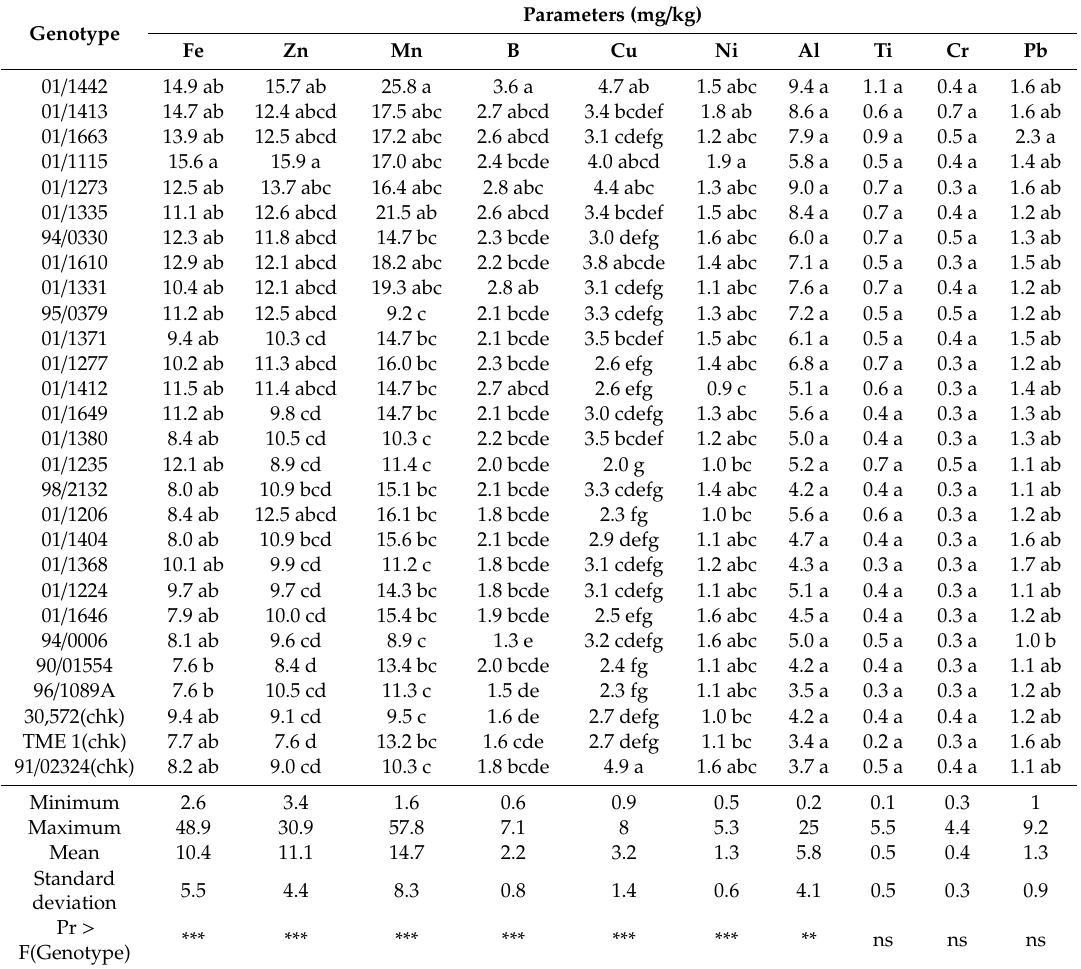
Table 3. Mean value of trace elements of yellow-fleshed cassava roots by genotypes and across five growing